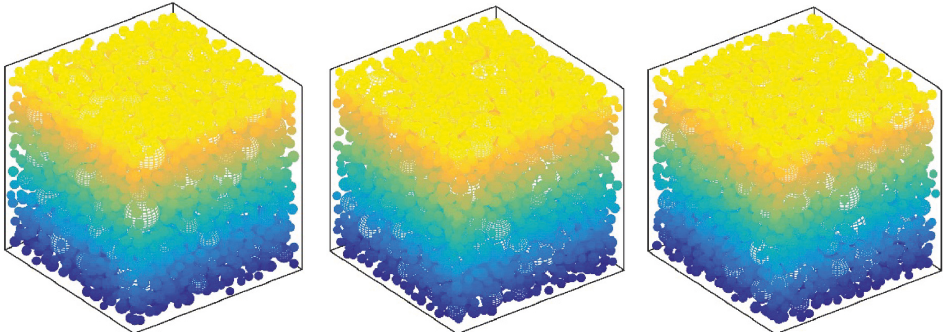
Figure 5: Geometric model of single-graded spherical aggregate. Table 1: Gradation of coarse aggregates.